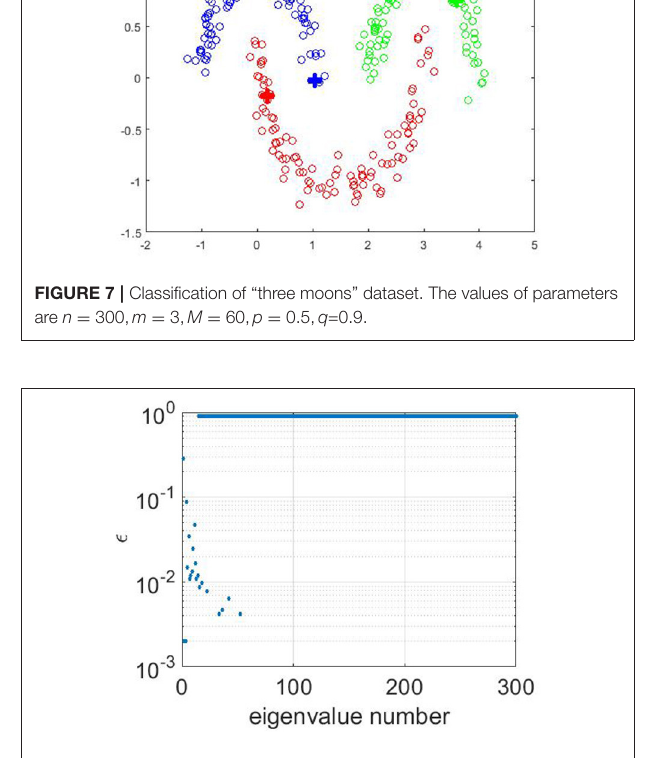
FIGURE 8 | Logarithmic plot of adaptively chosen ε for three-moon dataset. The values of parameters are n = 300, m = 3, M = 60, p = 0.5, q =0.9.